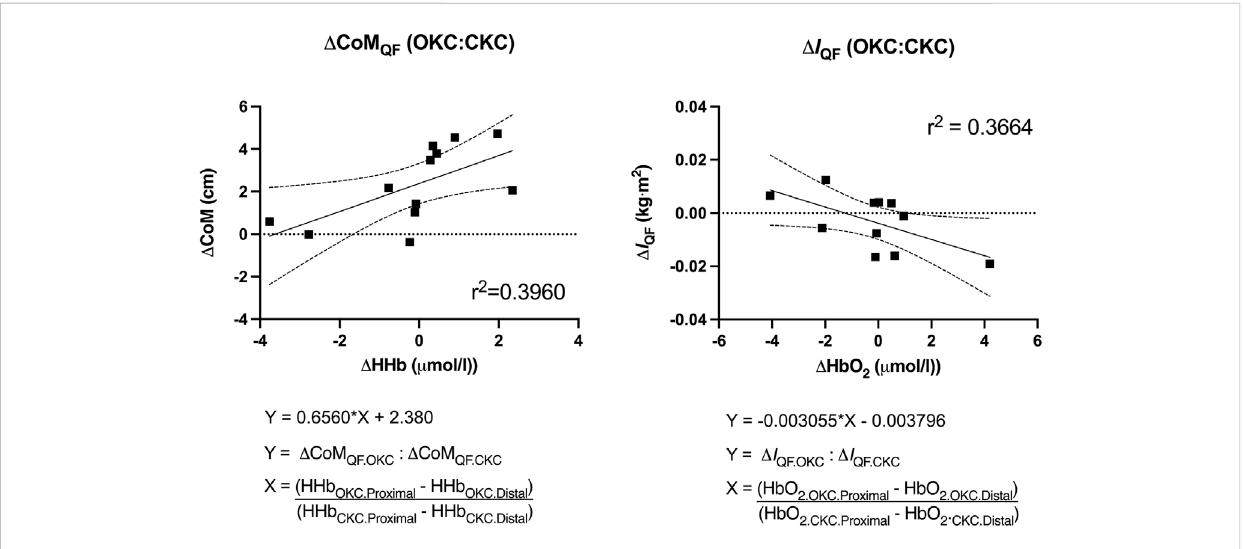
FIGURE 5 Predictive value of regional differences in near-infrared spectroscopy measures [deoxygenated (HHb) and oxygenated (HbO 2 )] within a single bout ofopen(OKC)andclosed-kineticchainexercise(CKC)exerciseinvastuslateralisonchangesinquadricepsfemoriscenterofmass(CoM QF )andmoment of inertia (I QF ) after 8-week of training ( p <